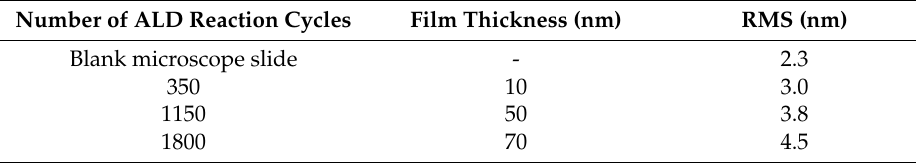
Figure 13. ( a ) Temperature dependence of sensitivity for 50 nm TiO 2 sensor after exposure to CO, CH 4 , NO 2 , NH 3 , SO 2 , ( b ) Electrical resistance and current response of TiO 2 gas sensors exposed to different concentrations of CH 4 and NH 3 under 0% RH at 480 °C and ( c ) Sensor signal for 10 nm and 50 nm thickness TiO 2 sensors.